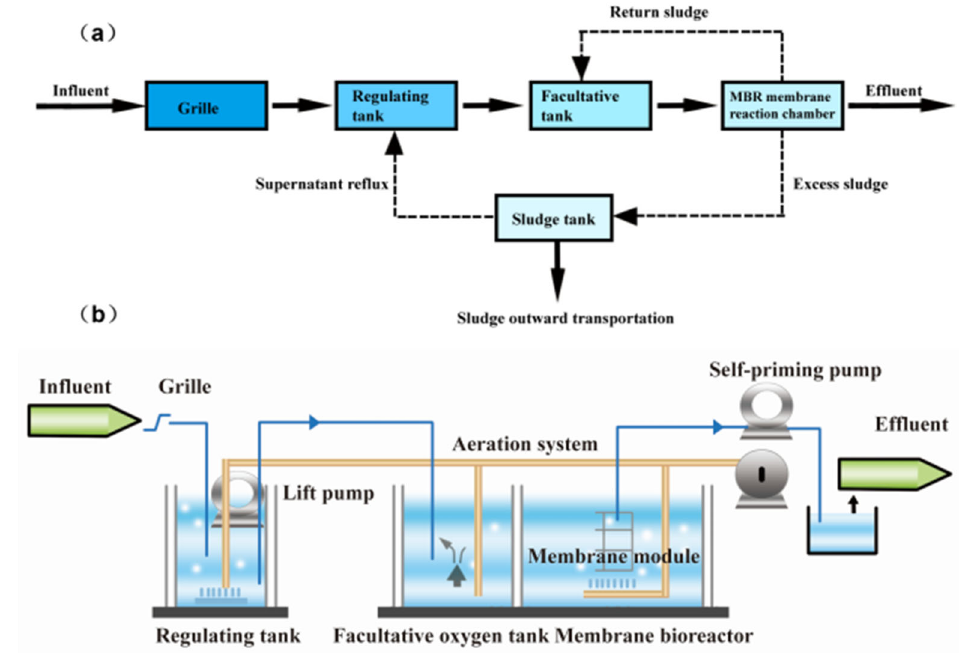
Figure 2. MBR process flow ( a ) and schematic diagram ( b ).